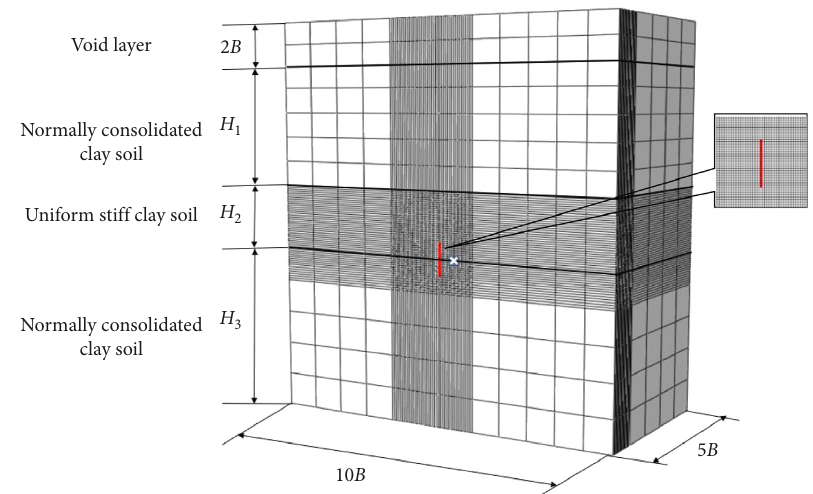
Figure 5: Mesh of the numerical